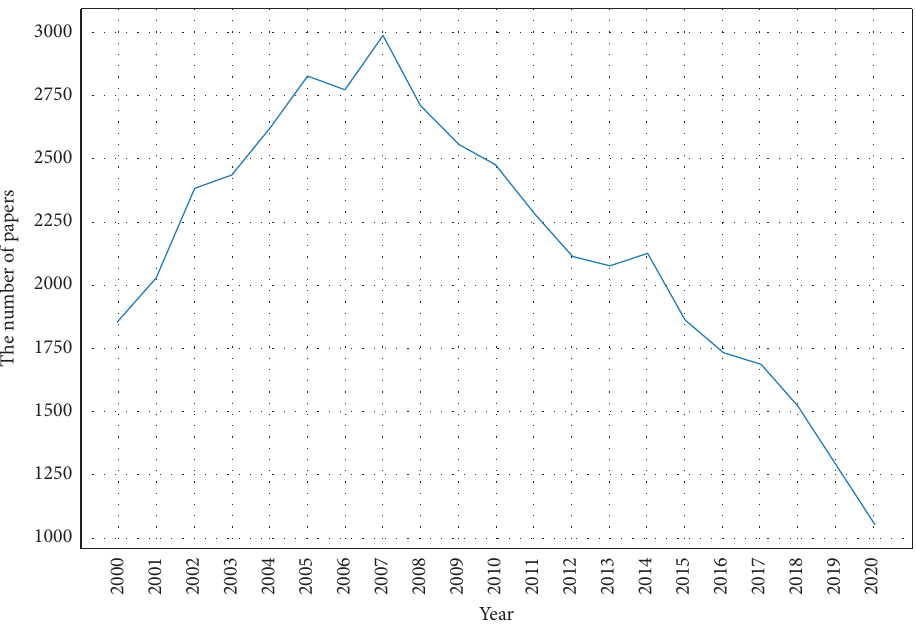
Figure 1: The trend of papers